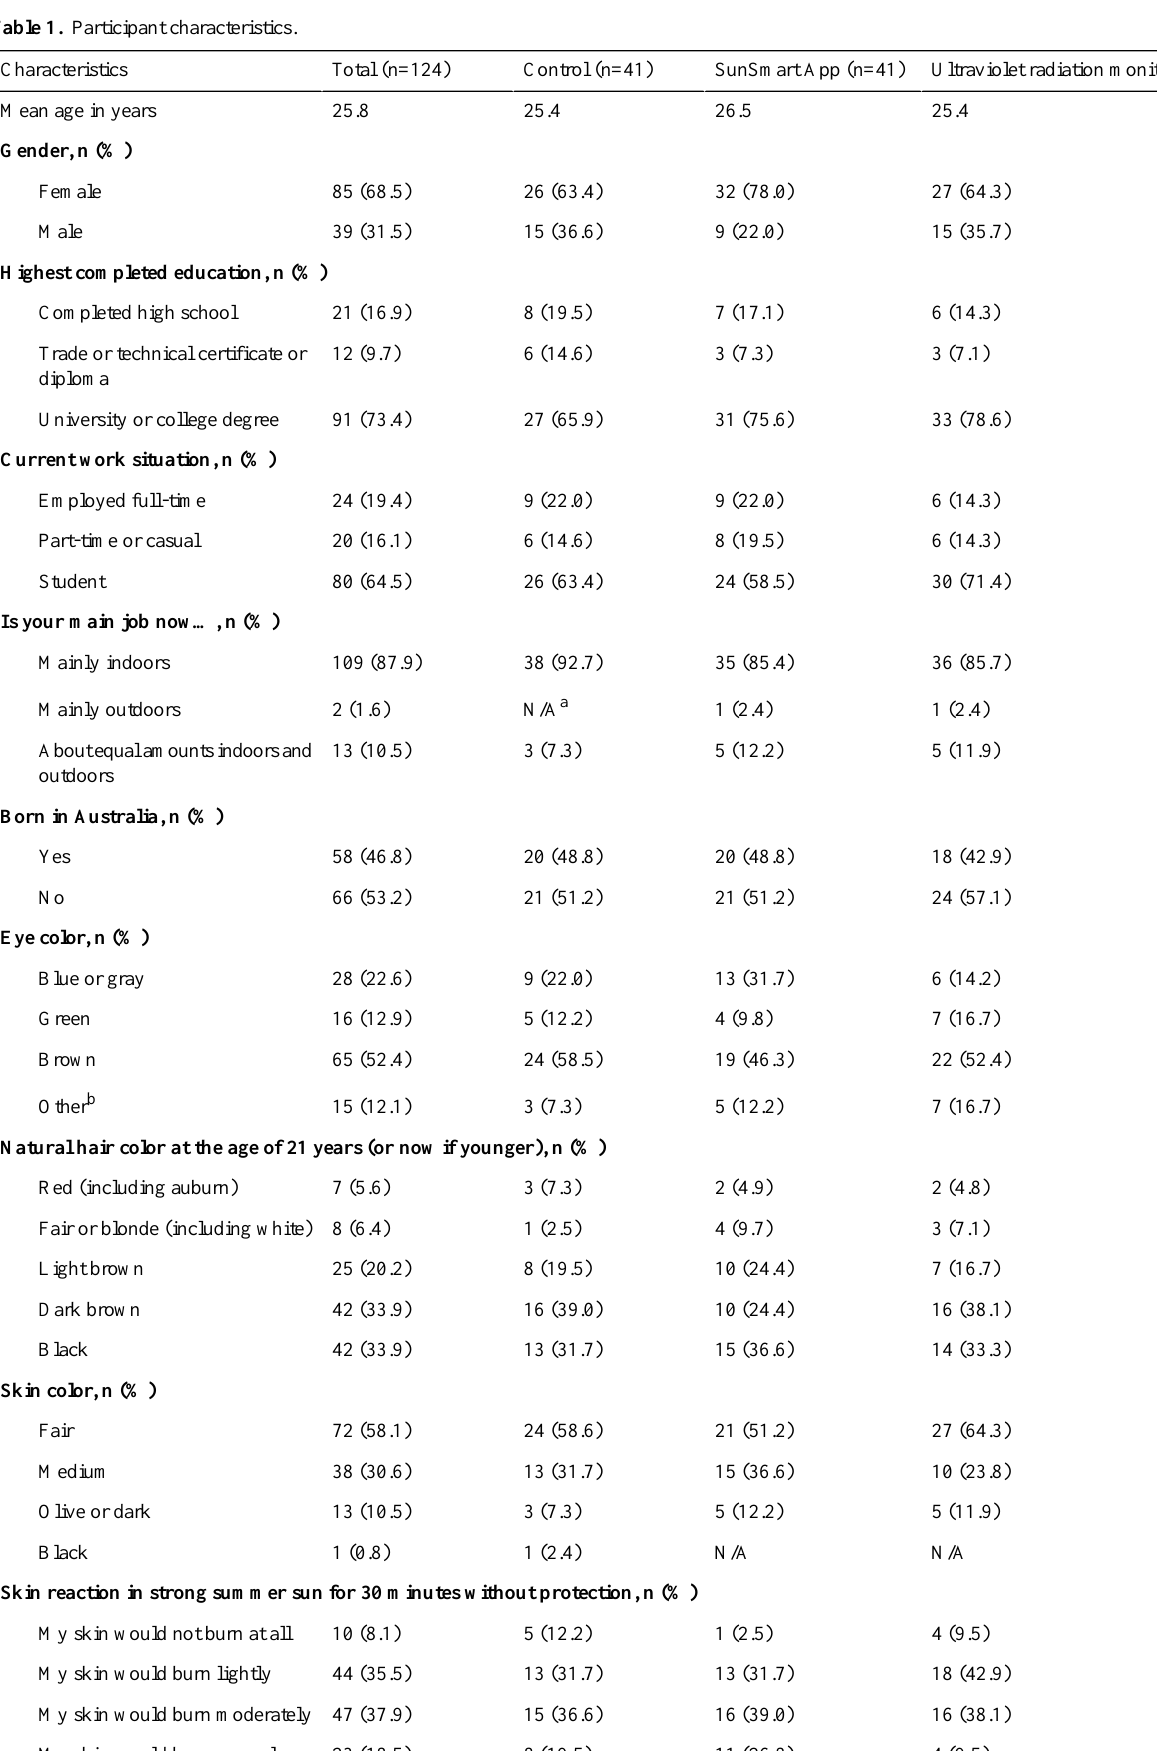
Table 1. Participant